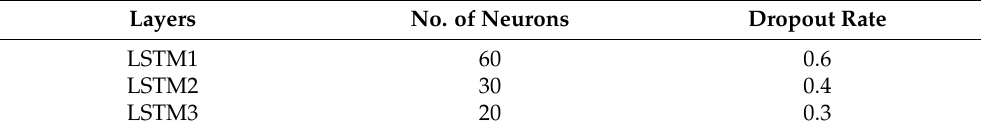
Table 2. Some key parameters of RNN models with the proportion of the input sequence α = 0.5. Layers No. of Neurons LSTM1